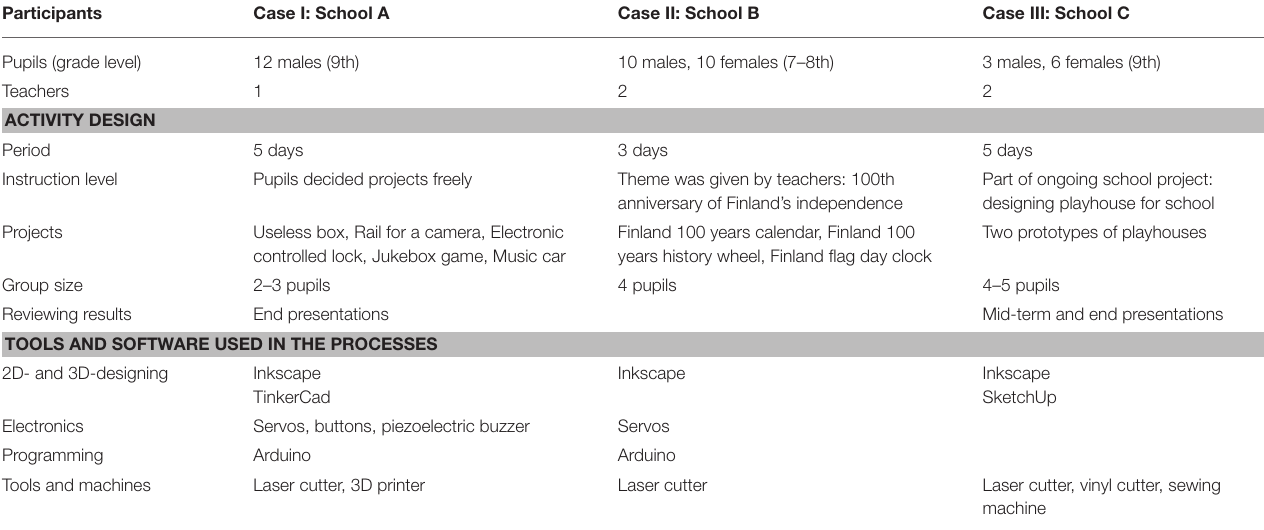
TABLE 2 | The participants of the three cases and the activity design and tools used in the cases.